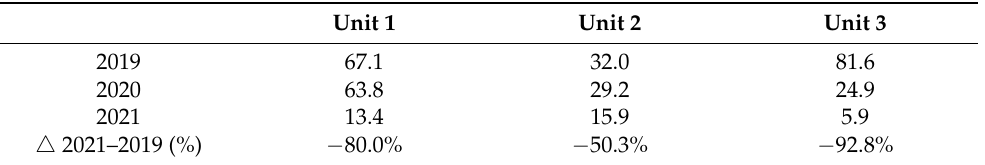
After the intervention, the FQs consumption decreased in all three units, respectively, by 80.0%, (from 67.1 DDD/100 bd to 13.4 DDD/100 bd), 50.3% (from 32.0 DDD/100 bd